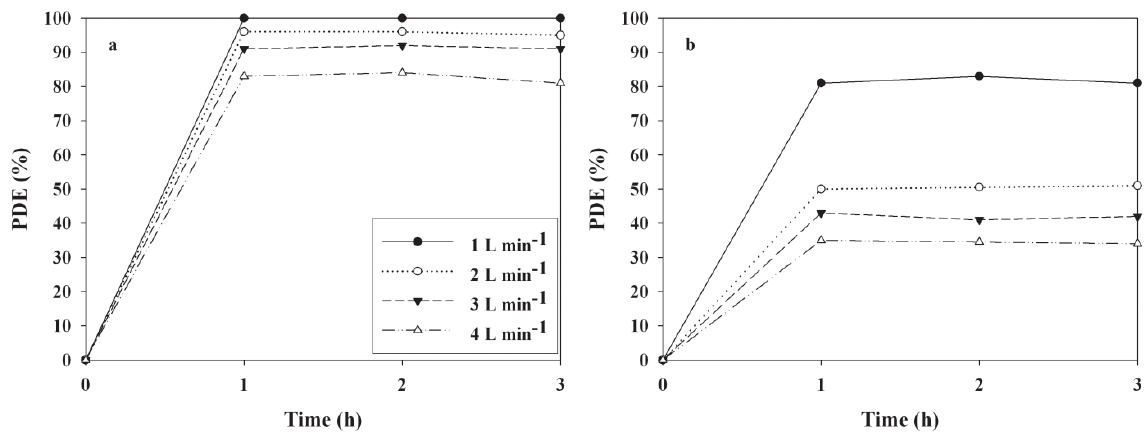
6. Time-series photocatalytic efficiencies (PDEs, %) of ( a ) 2-propanol; and ( b ) TCE as determined using TiO calcined at 450 o C according to flow rates (1.0, 2.0, 2 3.0, and 4.0 L min − 1